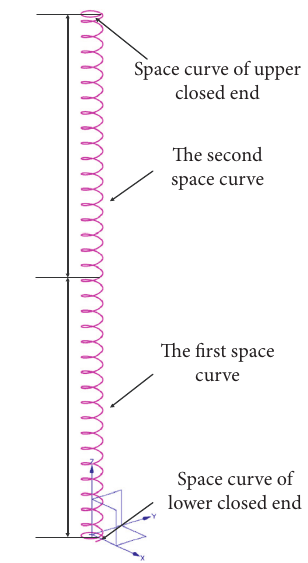
Figure 3: The center curve of strand of recoil